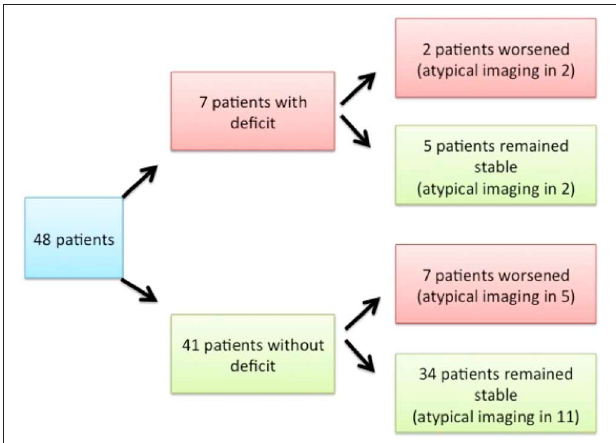
FIGURE 3 | Clinical exam upon presentation and clinical evolution of patients.